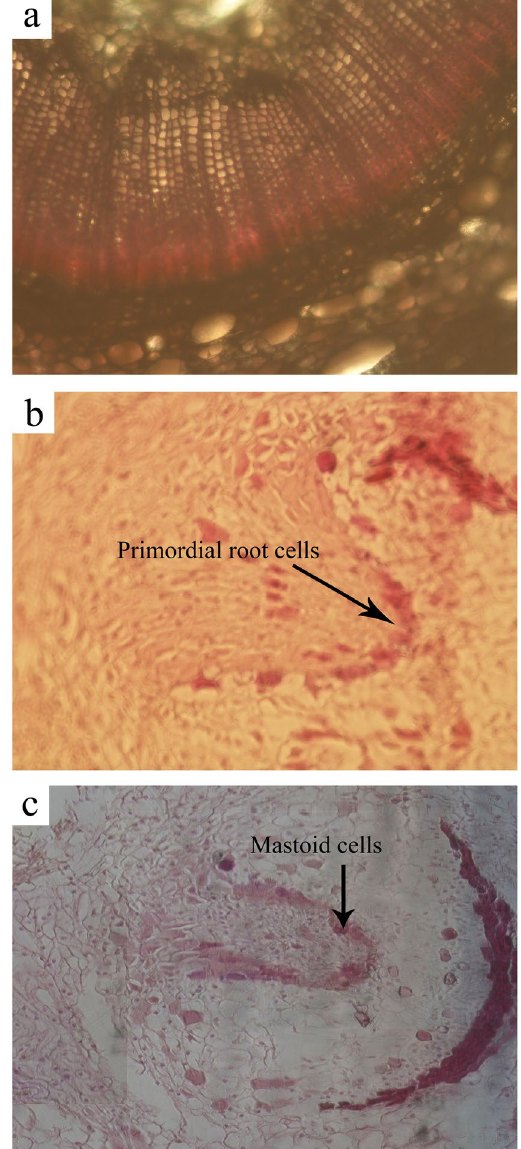
Figure 4. Light microscopy images of rooting from a leaf cutting taken from Chinese fir at 400 × magnification. ( a ) Leaf segment before cutting from the mother plant; ( b ) primordial root originating from calli 40 days after cutting; ( c ) expansion and extension of primordial cells and peninsula tissues in callus initiation 50 days after